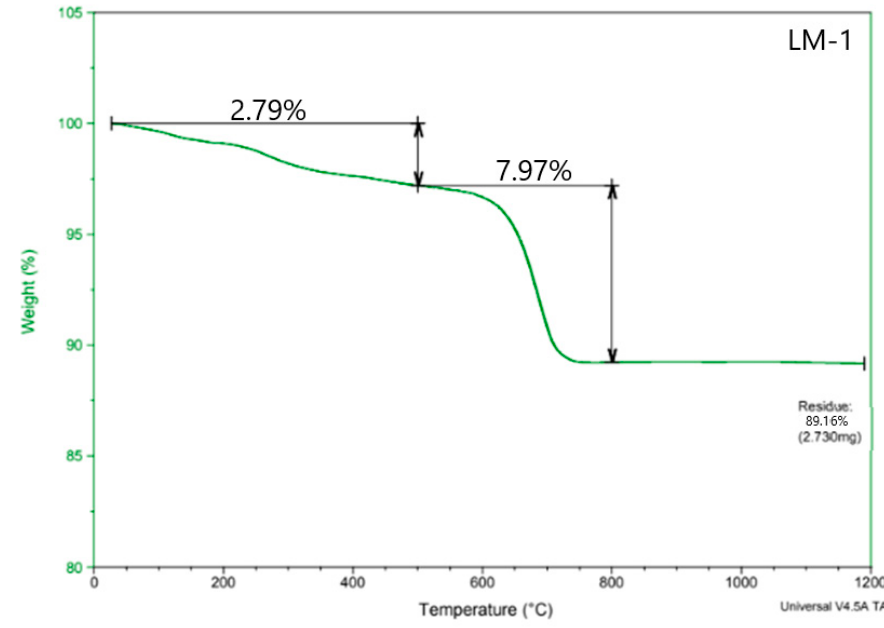
Figure 3. TGA-DTA pattern of the 28-days mortars: LM-1 Reference lime mortar ( a ) kadukkai; ( b ) cactus; ( c ) hibiscus; ( d ) aloe vera; ( e ) jaggery; ( f ) neelamari; ( g ) kadukkai + jaggery; and ( h ) kadukkai + jaggery + aloe vera (MXD).